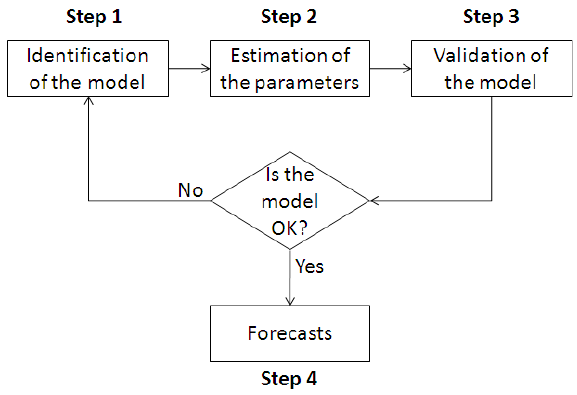
Figure 3. The Box-Jenkins